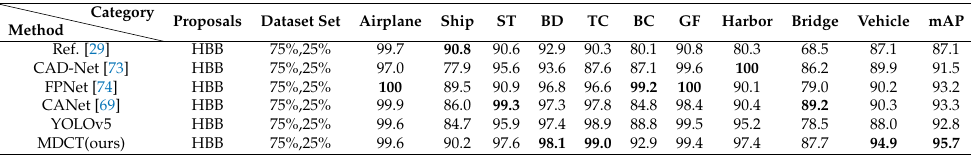
Table 3. The outcomes of various detection algorithms on the NWPU VHR-10 dataset. The highest AP in each category is highlighted in bold. The mAP ( × 100) represents IOU = 0.5. The Dataset Set represents the training set and test